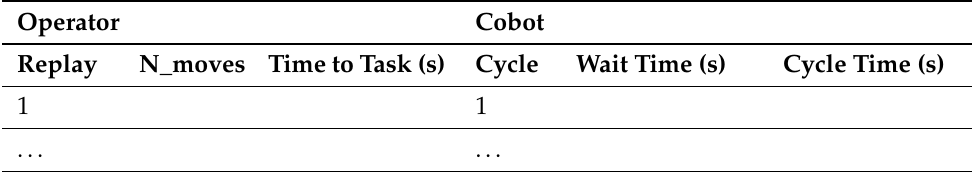
Table 4. Form to Experimental Scenario (TOH5+CA). Tasks: Solve problem (main) and Collaborate with cobot (secondary).